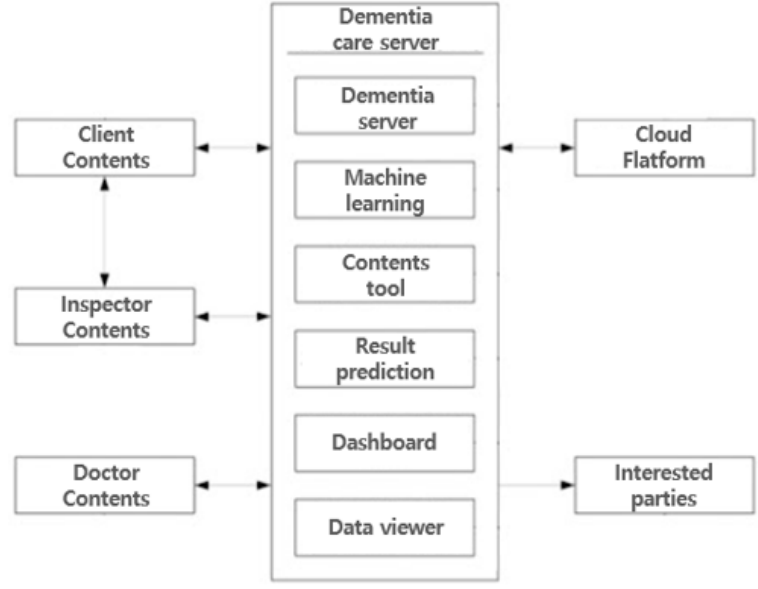
Figure 4. Component block diagram of the dementia testing management server using machine learning.